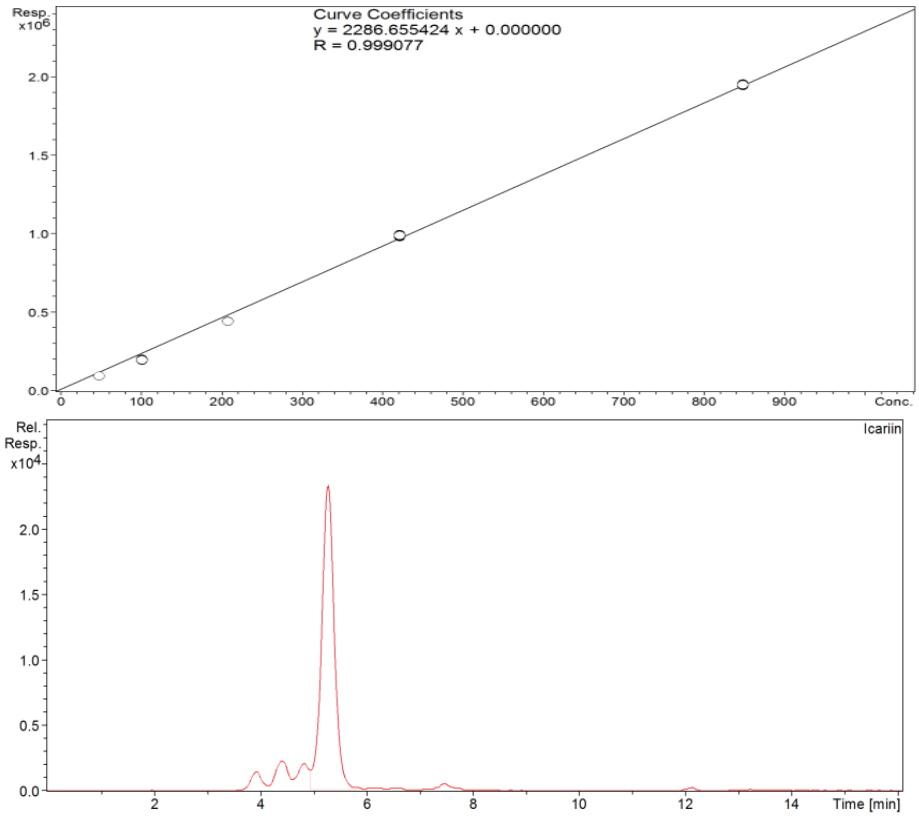
Figure 1. Calibration curve and chromatogram of icariin in Epimedium L. (Species: Epimedium Koreanum ) extract indicating its content of 168.90 ng/ml.